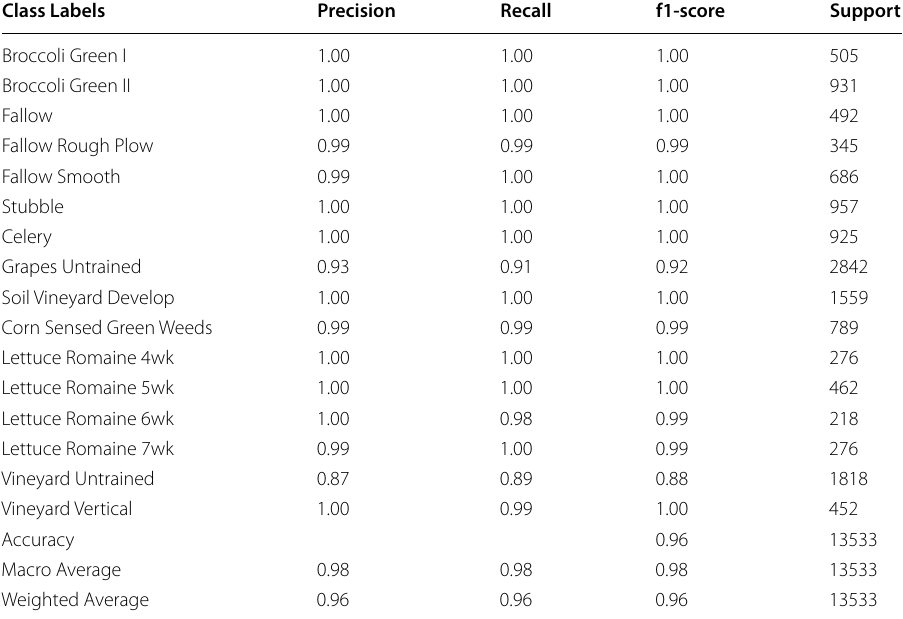
Table 13 Detailed classification test results for the Salinas Dataset in terms of Precision, Recall, and F1-Score. Testing was done with PCA 30 CEU-Net no-patching with a 75%/25% Training/Testing split